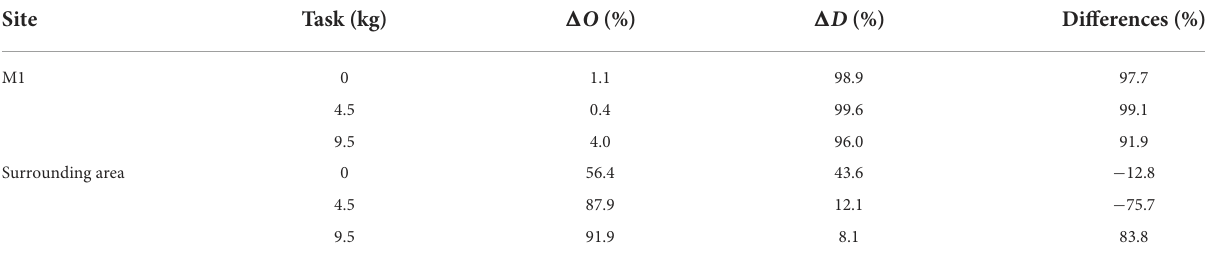
TABLE 2 Average contribution to L and differences in the relative contributions of 1 D and 1 O during a